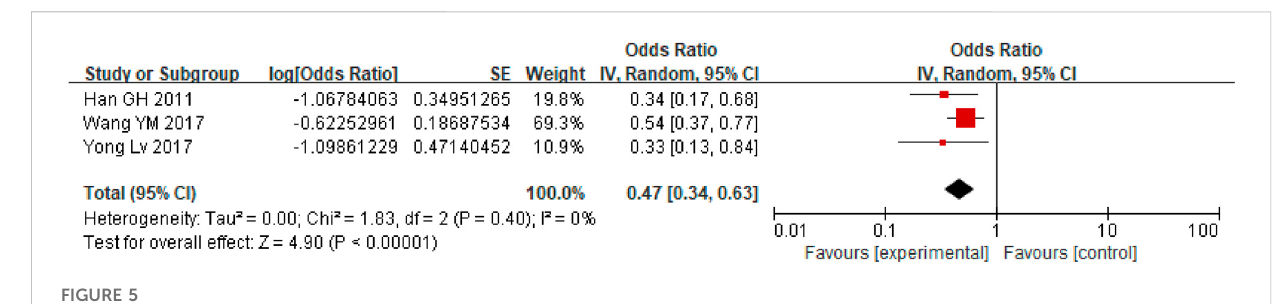
FIGURE 5 The occurrence of hepatic encephalopathy.